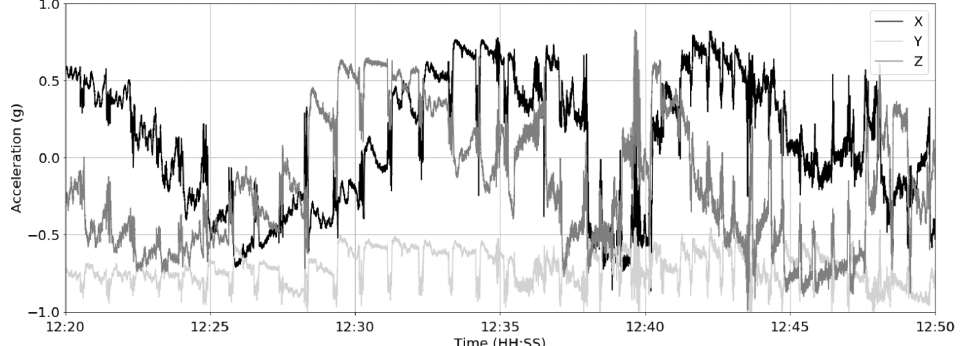
Figure 3. Example of raw 3-axis accelerometer data over a 30 min window at 10 Hz sampling